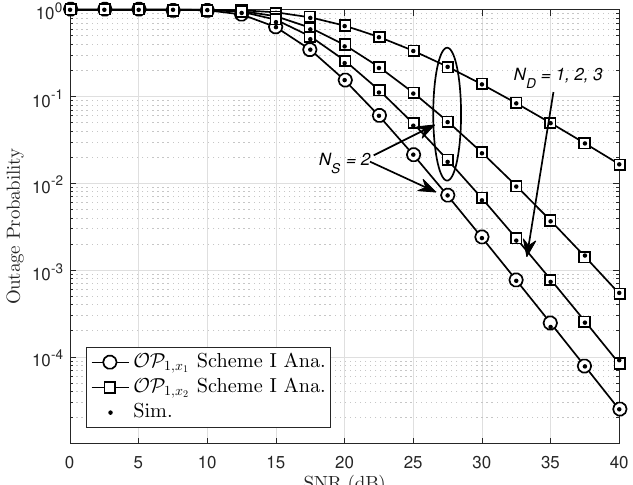
Figure 3. Outage probability of Scheme I with different N D , N S = 2, d 1 = 2 m, d 2 = 3 m, a 1 = 0.2 and a 2 =